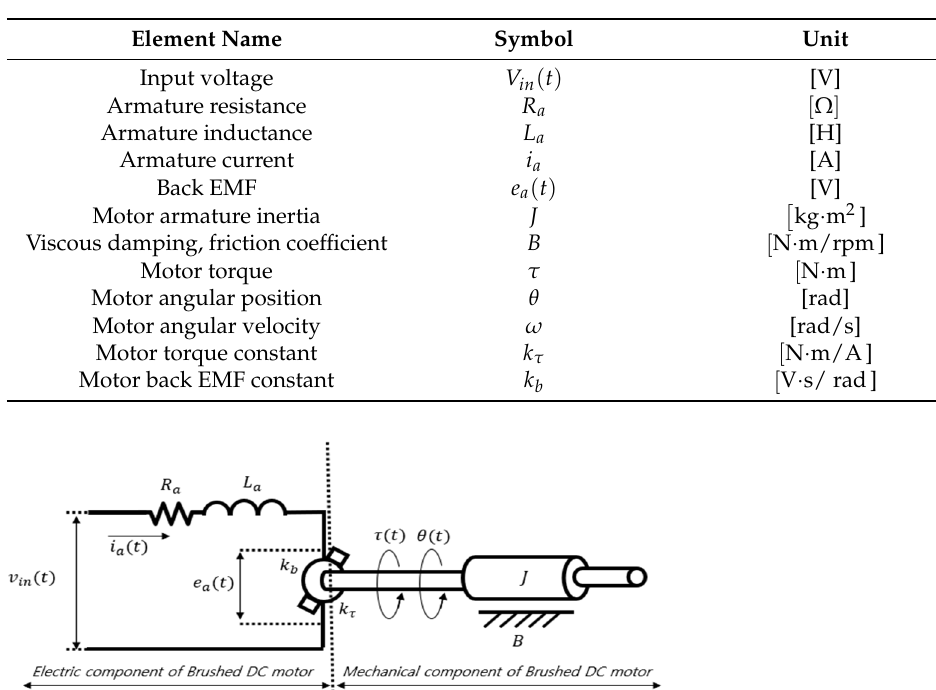
Table 1. Names and symbols of electrical and mechanical elements.